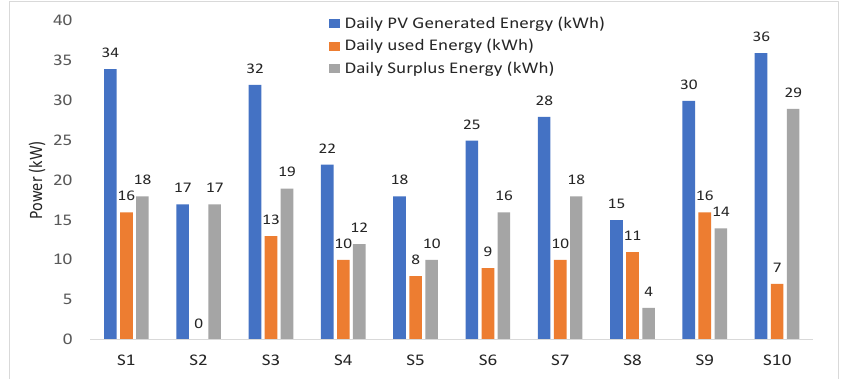
Figure 3. Sellers’ PVs generated, consumed, and surplus energy throughout one